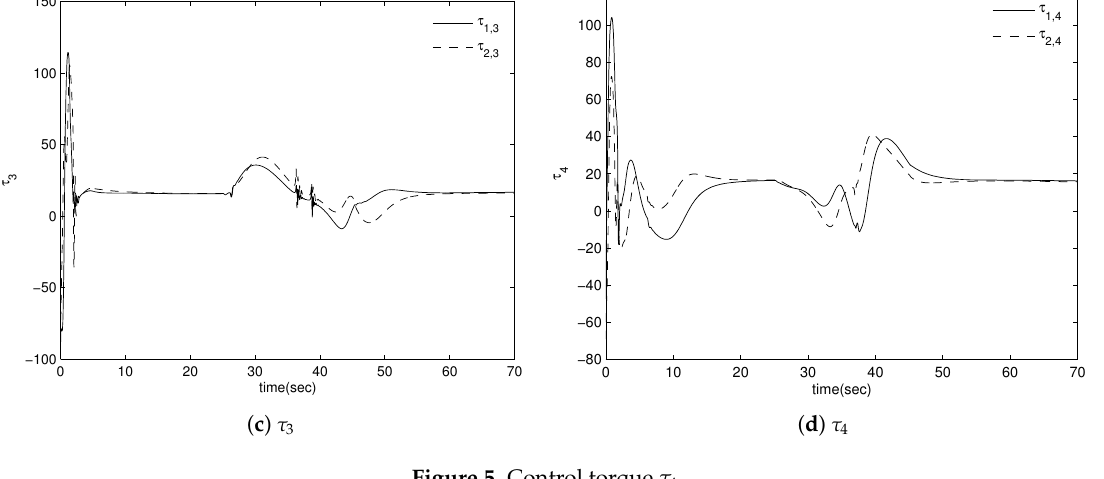
Figure 5. Control torque τ j .